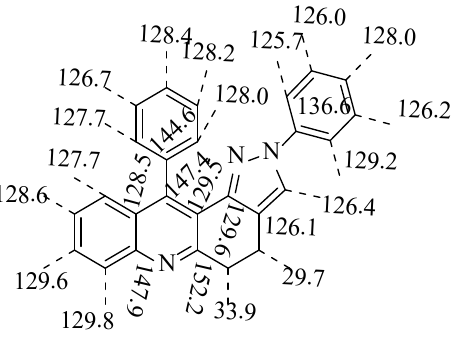
Figure 8: Summary of Carbon d Values of